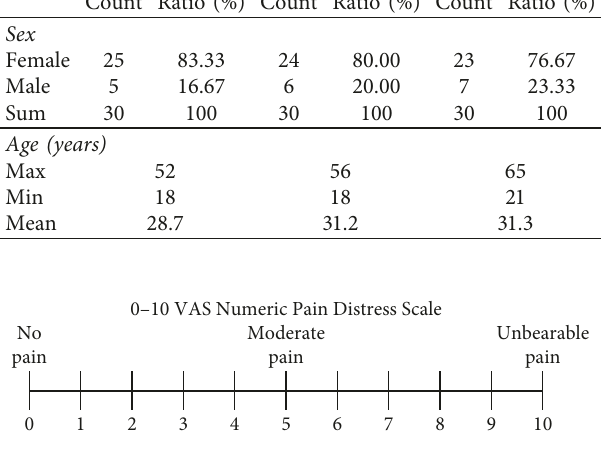
Figure 1: VAS example. Source: http://trialdatasolutions.com. Q1. Pain constricted my everyday activity (eating, getting dressed, taking showers, shopping etc.). no definitely 0123456789 10 yes definitely